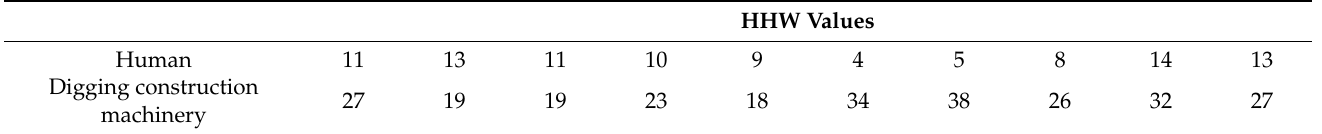
Table 2. Half-height width values of 10 groups of human radar data and the digging construction machinery positions.